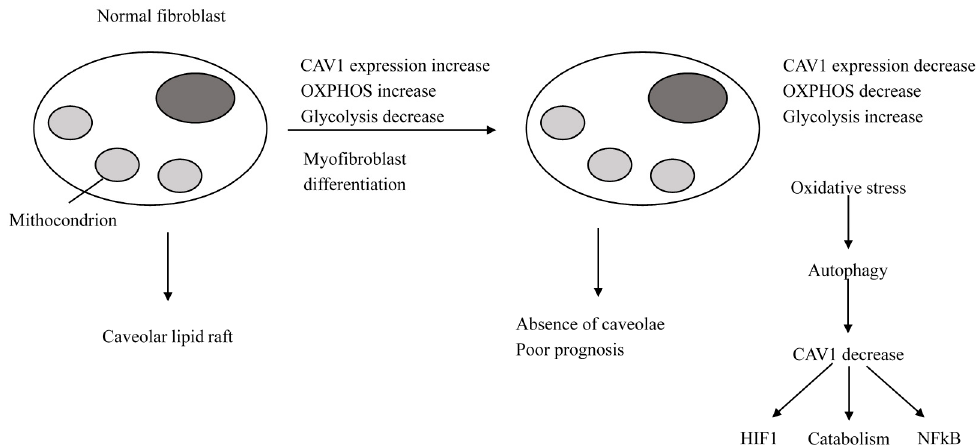
Figure 3. CAV1 expression in normal fibroblasts and in cancer-associated fibroblasts (CAFs). During myofibroblast differentiation, fibroblasts lose CAV1 expression, which accounts for a CAF phenotype. This is characterized by lower oxidative phosphorylation (OXPHOS) and higher glycolysis. Conversely, a normal fibroblast phenotype is associated with elevated CAV1 expression, active OXPHOS and low glycolysis. Loss of CAV1 expression in fibroblasts is associated with poor outcome in breast cancer (also see text).